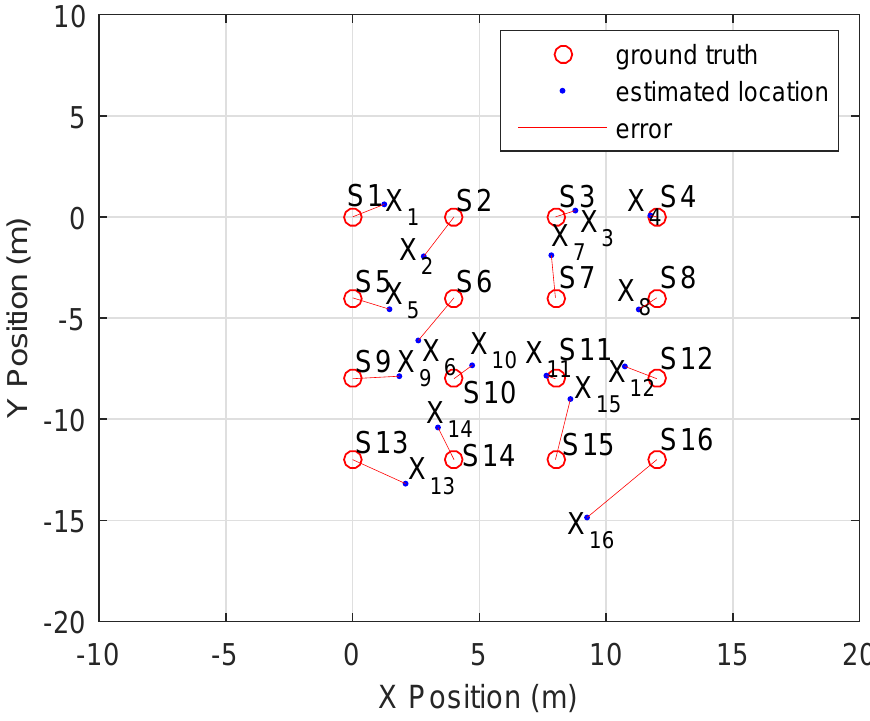
Figure 11. Localization results. The RMSE is 1.97 m.